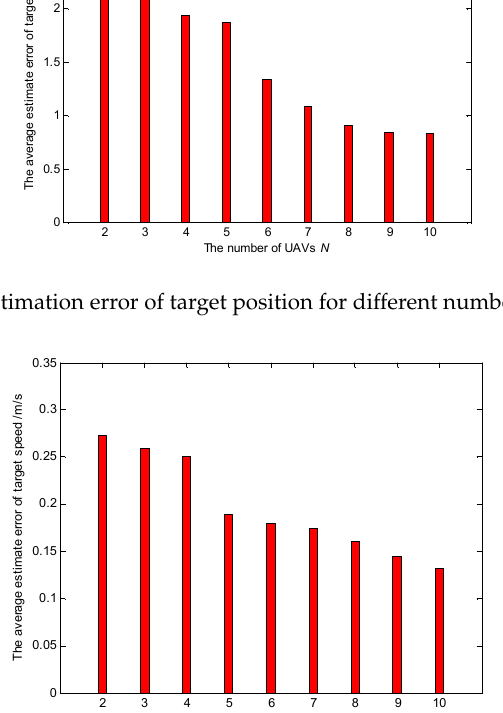
Figure 39. The average estimation error of target direction for different numbers of UAVs (Scenario 5). 2